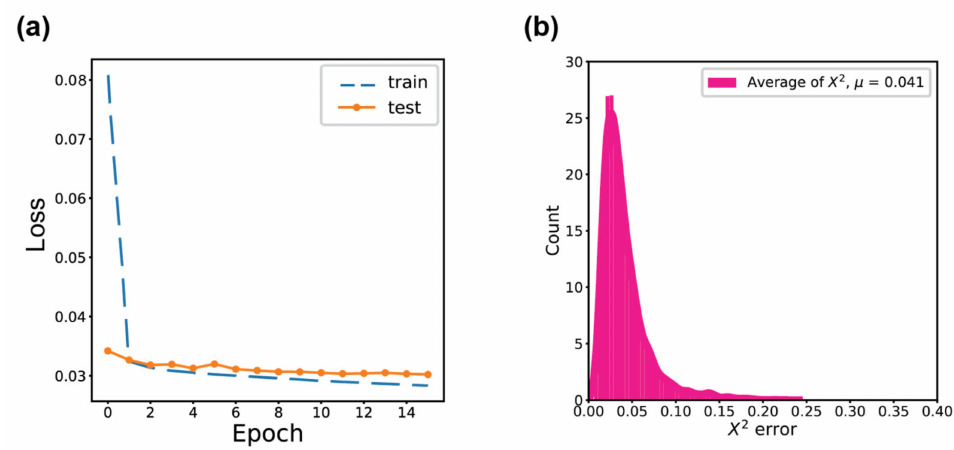
Figure 3. ( a ) The training and validation loss as function of training epoch, ( b ) the histogram of X 2 error for the test